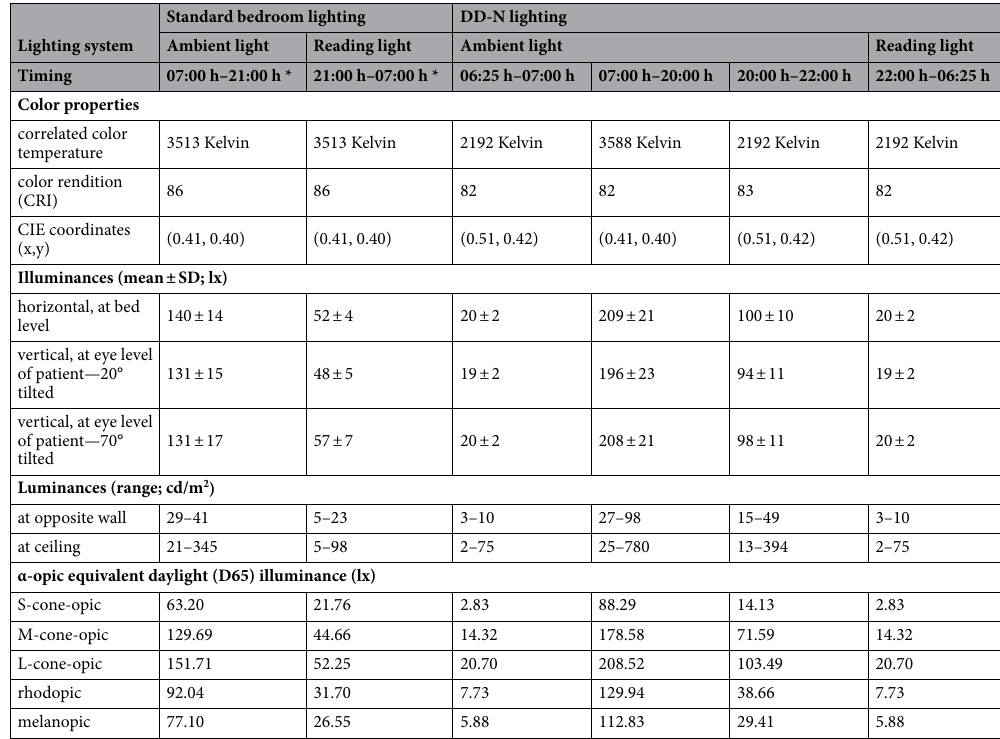
Table 2. Photometric characterization of the lighting interventions. Spectral irradiances and illuminances were measured with a spectroradiometer (specbos 1211-2, JETI Technische Instrumente GmbH, Jena, Germany) and color properties were calculated with the software JETI LiVAl; luminances were measured with a calibrated CANON EOS 650D camera with fisheye optic; the alpha-opic irradiances were derived from the